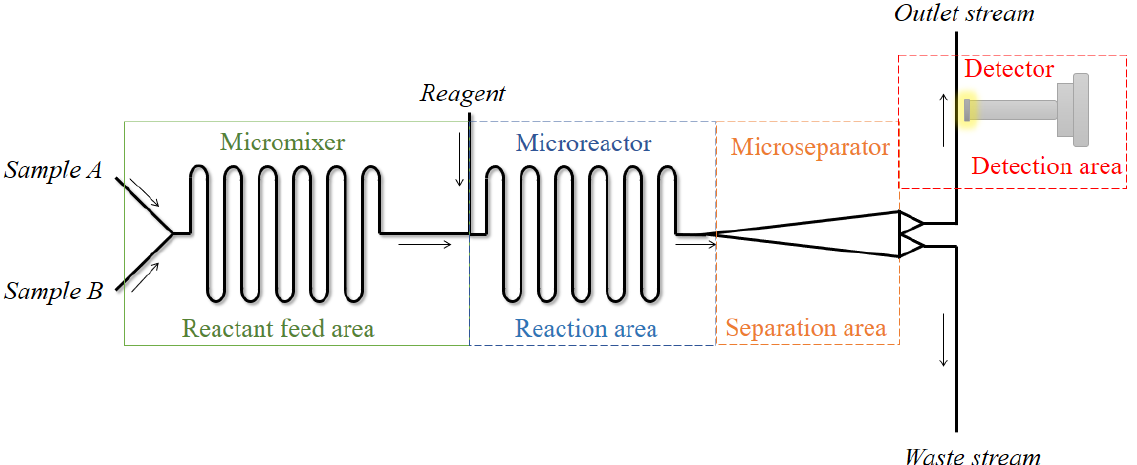
Figure 2. Micro-total analysis system ( μ TAS) scheme.